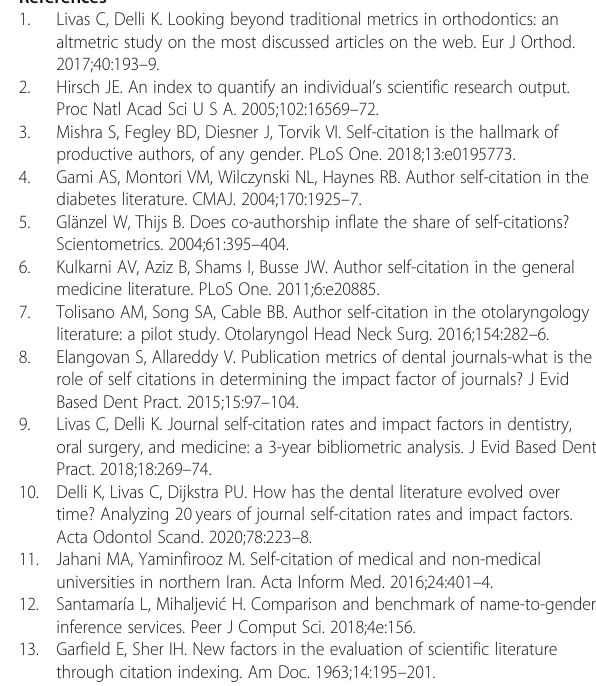
Additional file 1: Figure S1. Distribution of self-citations by rank, study type, journal, and number of authors. Additional file 2: Figure S2. Distribution of self-citations by